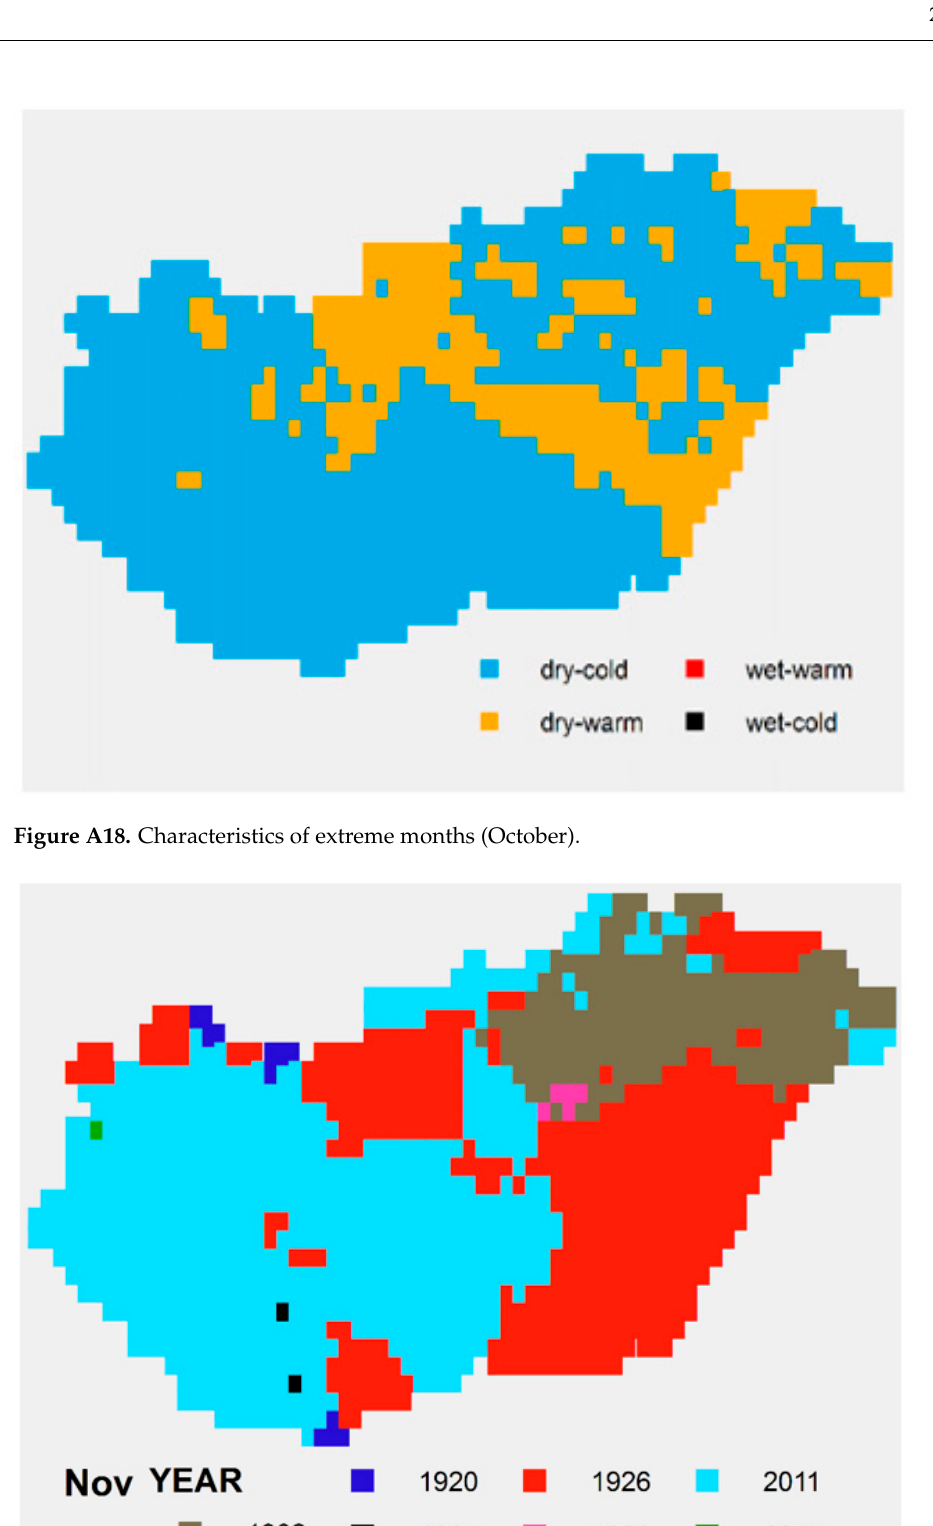
Figure A19. November: Year of maximum SPTI values, 1871–2020.